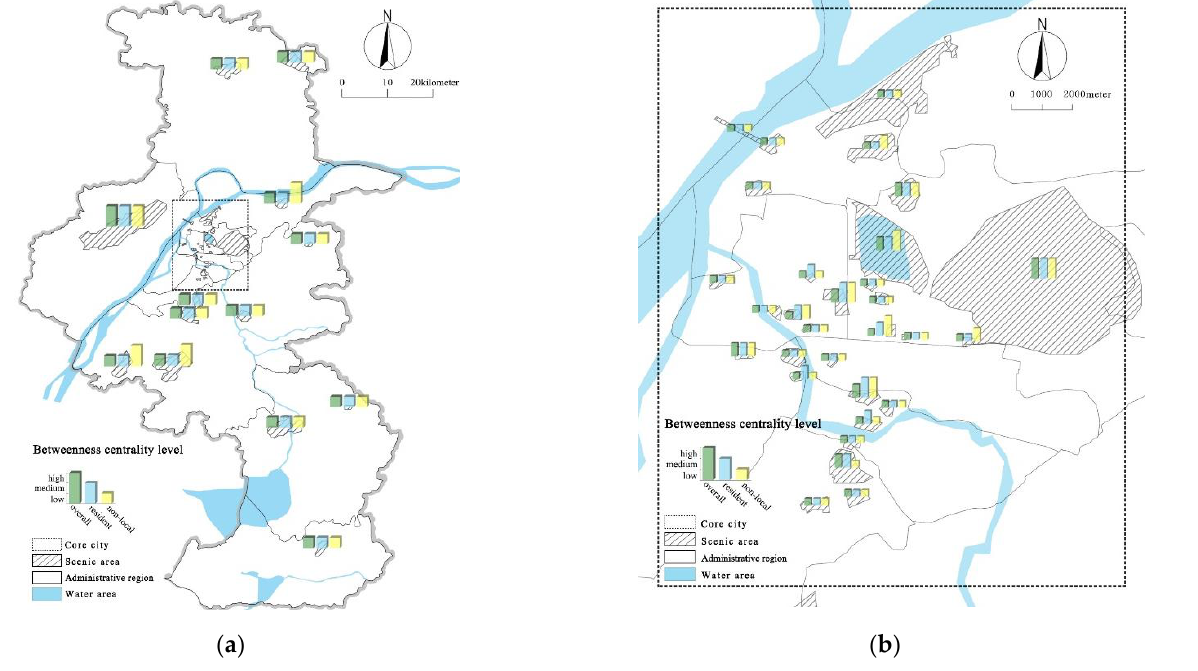
Figure 7. Classification map of the betweenness centrality of nodes under three types of network context (overall, resident, and non-local tourist): ( a ) entire city of Nanjing; ( b ) core city of Nanjing.